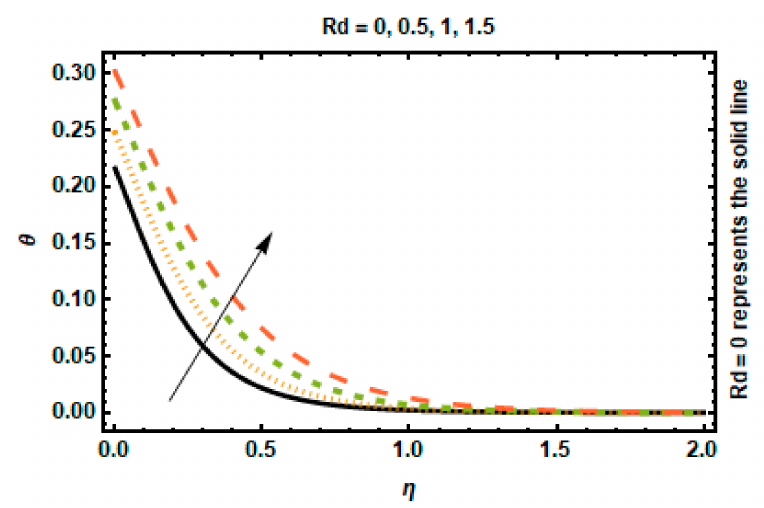
Figure 8. Effects of Rd on